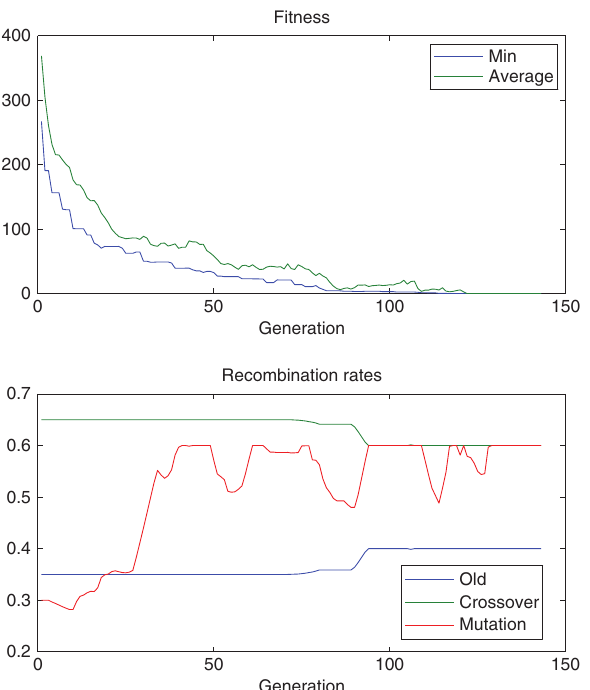
Figure 3: Rastrigin Function Minimization: Trend of GA Average Population and Best Individual Fitness (Upper Figure) and Recombination Rate (Lower